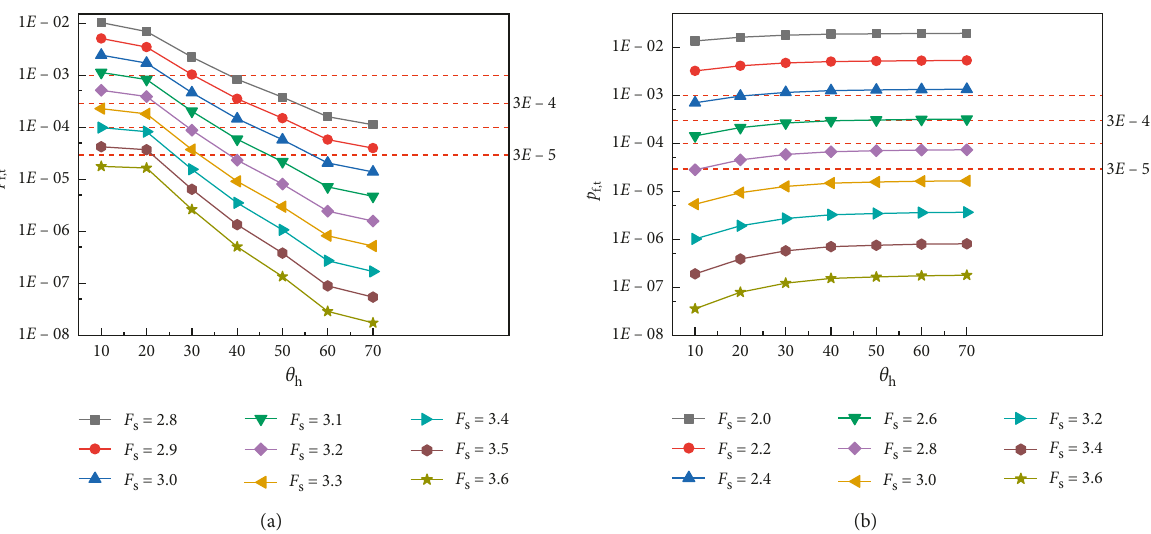
Figure 13: Probability of tension failure of tunnel liner under different random fields as a function of the horizontal correlation length and factor of safety: (a) CRF and (b) URF.